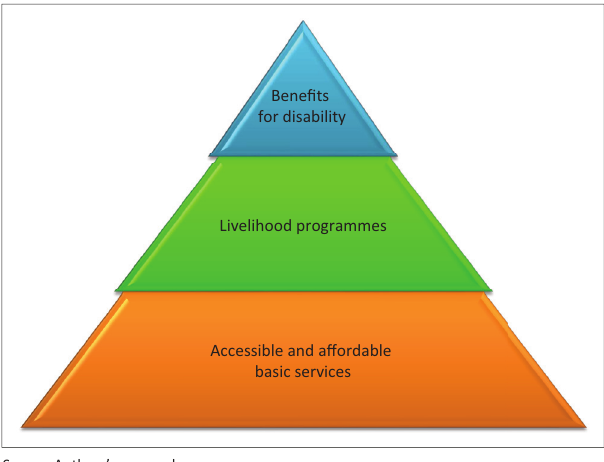
FIGURE 4: Triple social protection mechanisms to ensure participation of people with